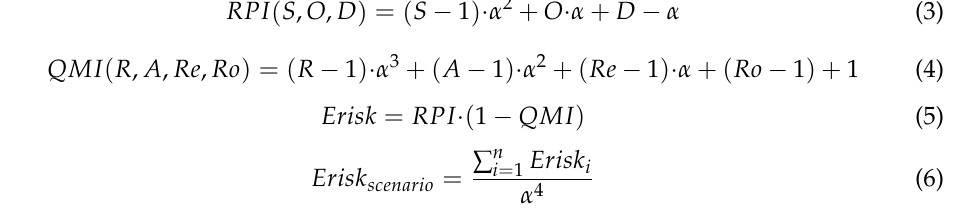
Table 1. Failure modes with greater impact in project management for open innovations (Dikert et al. 2016). FM